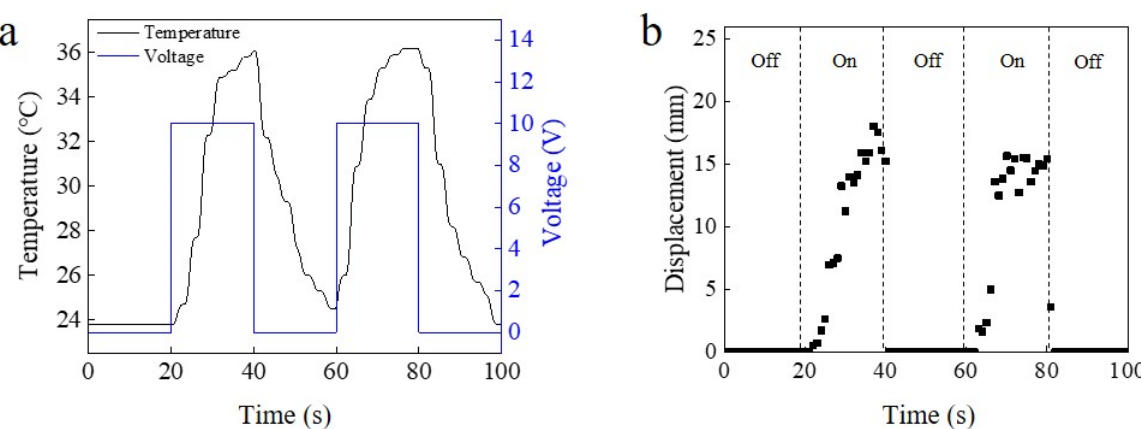
Figure 3. Diving/surfacing cycle of PNIPAM device stimulated by electricity. ( a ) Temperature change of PNIPAM device with inserted heating wire for electrical heating in water. ( b ) Diving/surfacing cycle of the tip of an electrically controlled cantilever device with turning on and turning off of the voltage applier.